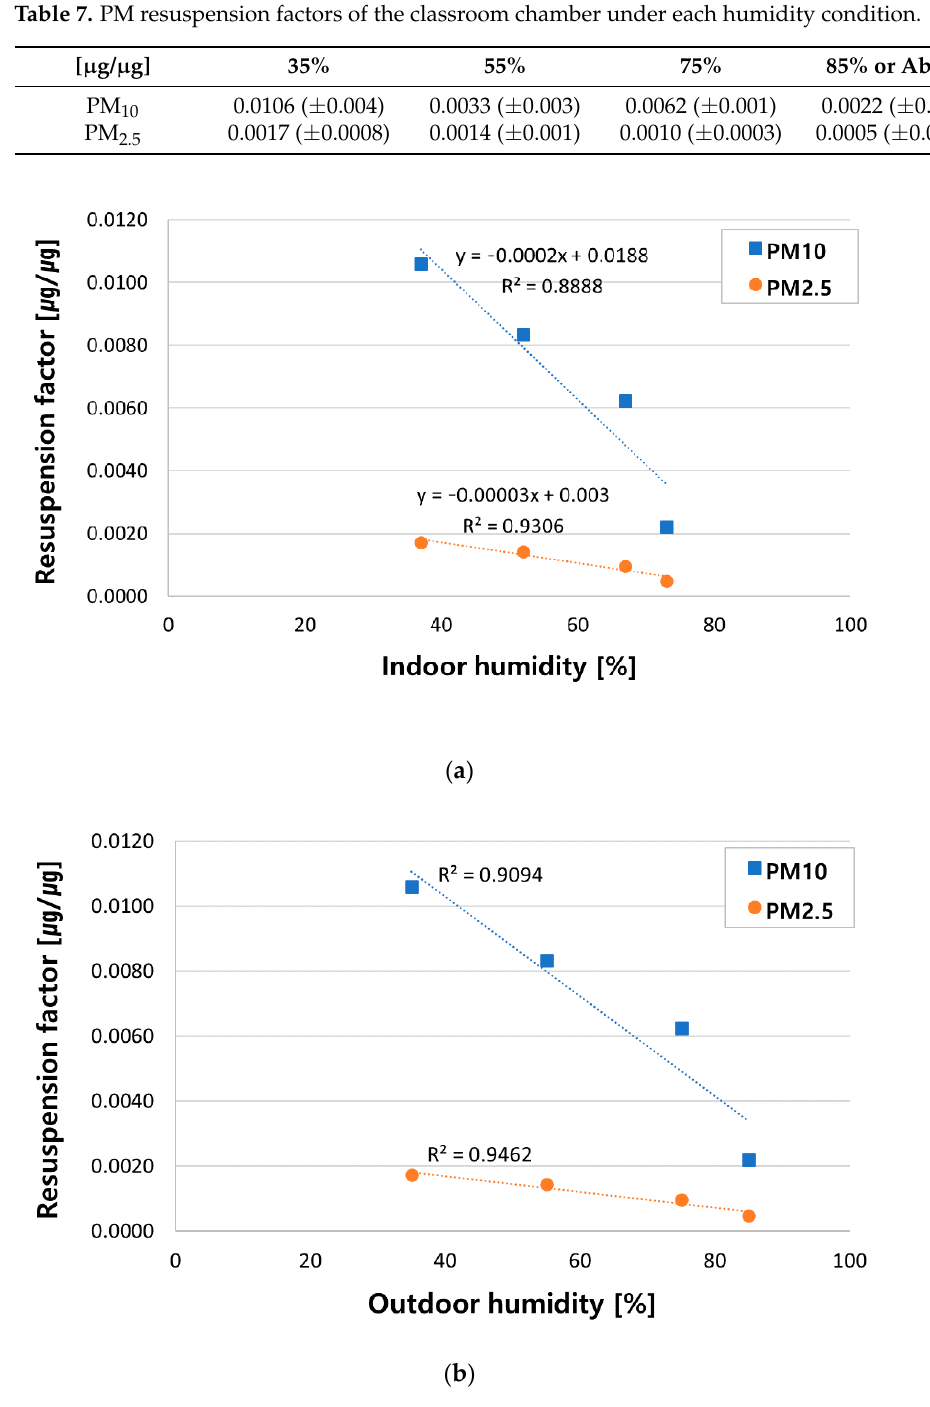
Figure 8. Comparison of PM resuspension factor under each condition of ( a ) indoor and ( b ) outdoor humidity of the classroom chamber.